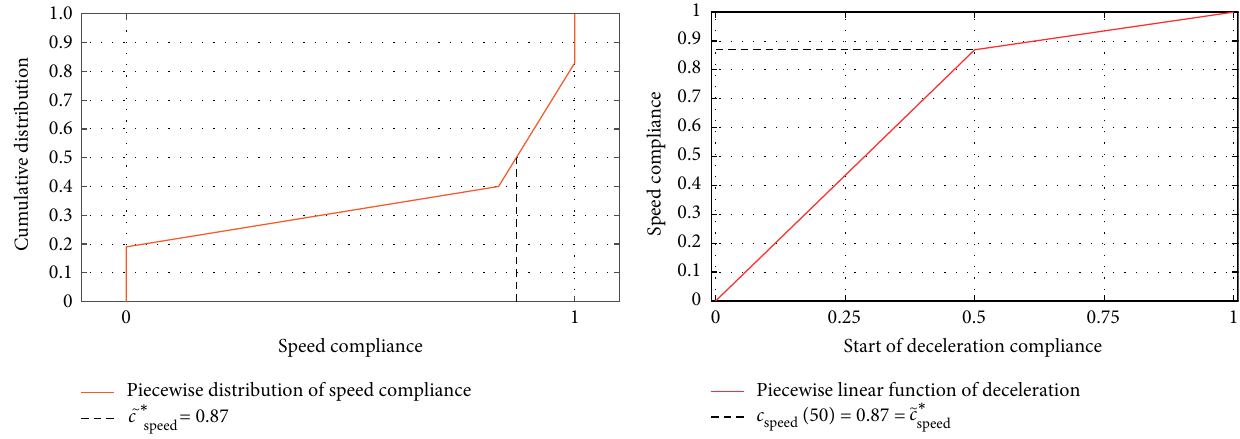
Figure 7: Piecewise linear distribution of deceleration compliance 𝑐 deceleration (right) and how it is related to the piecewise linear distribution of speed